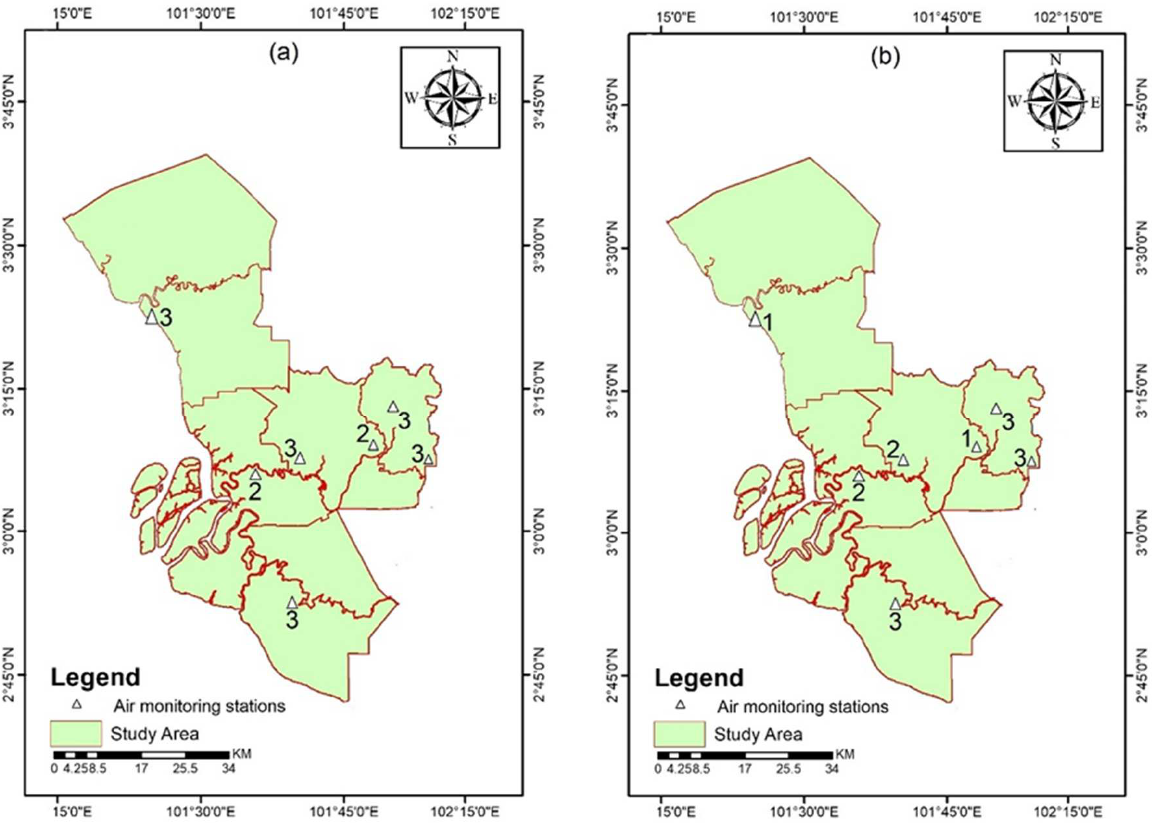
Figure 4. The optimum order of the MC model for the observed ( a ) hourly and ( b ) daily API.